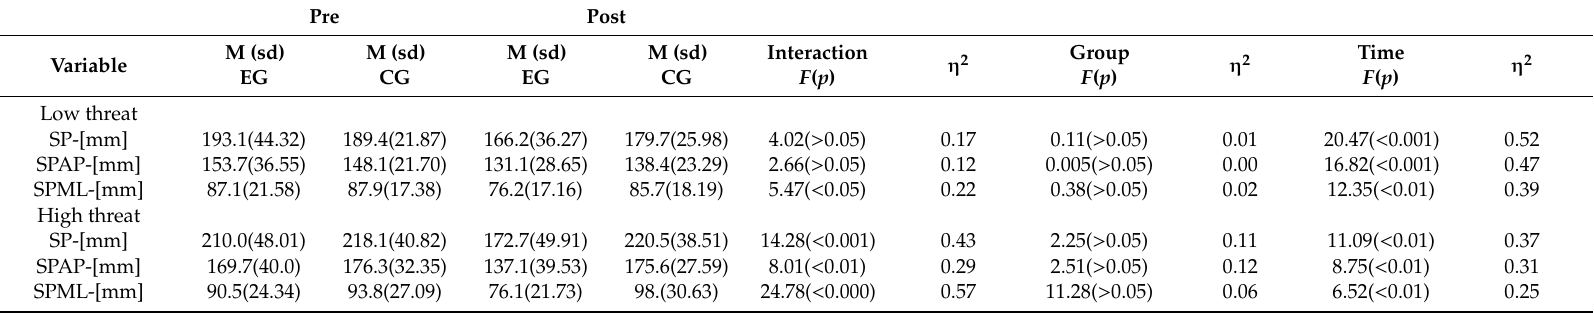
Table 2. Mean and standard deviation values of postural stability for quiet standing measures with eyes open on low and high threat in the experimental and the control groups before and after intervention and results of two-way ANOVA.